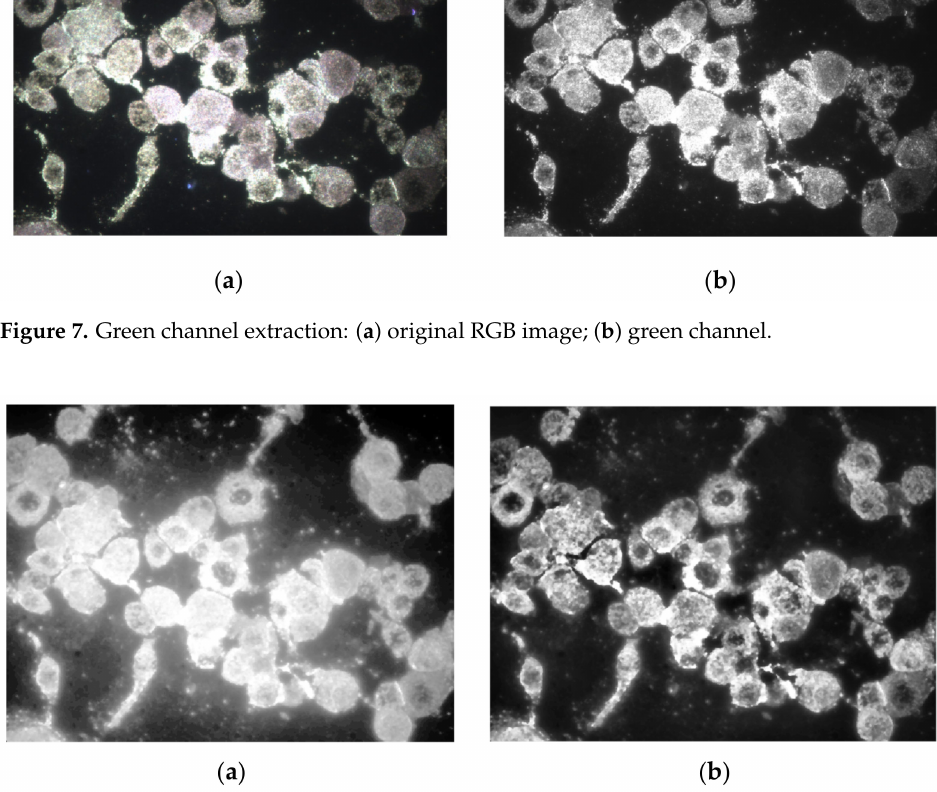
Figure 8. ( a ) Global contrast equalization; ( b ) adaptive contrast